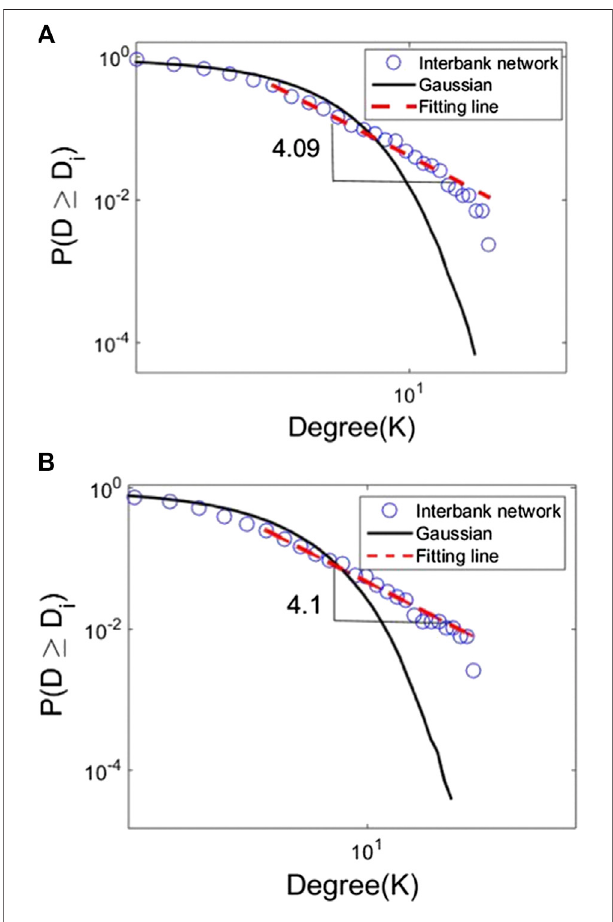
FIGURE 3 | The CDF for the degree of the interbank network is plotted with a double logarithmic scale. The cumulative distribution function for the degree ofnetwork during four years (A) from 2006 to 2009 and (B) from 2010 to 2013, the Gaussian distribution, and the fi tted line are denoted using dotted blue lines, a black line, and dashed red lines, respectively.